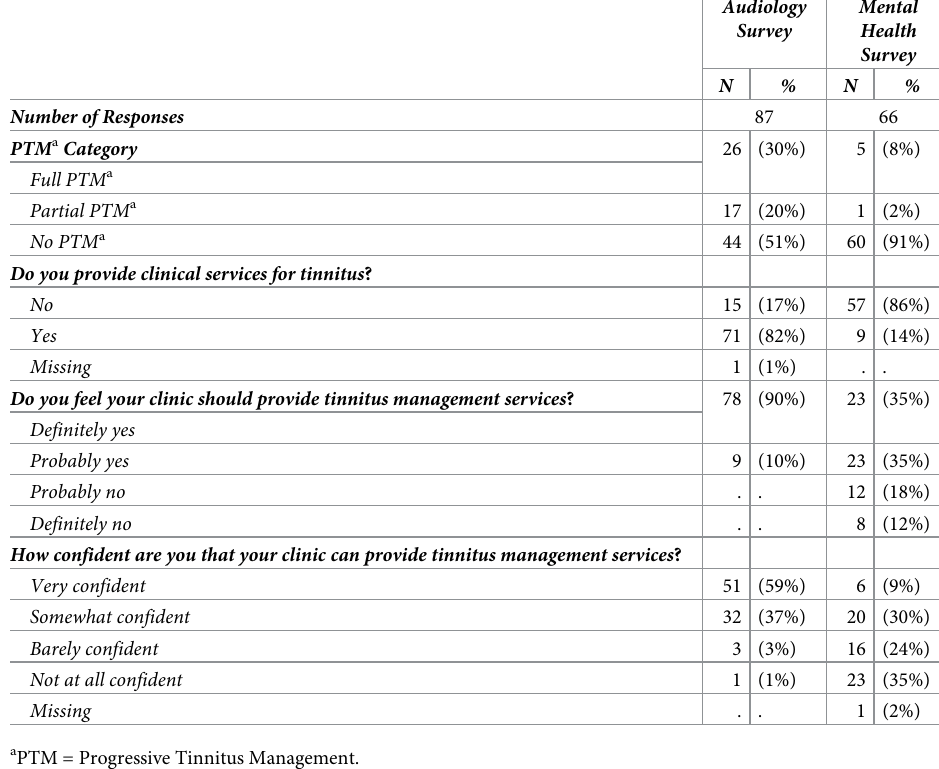
Table 2. Provision of tinnitus care at respondents’